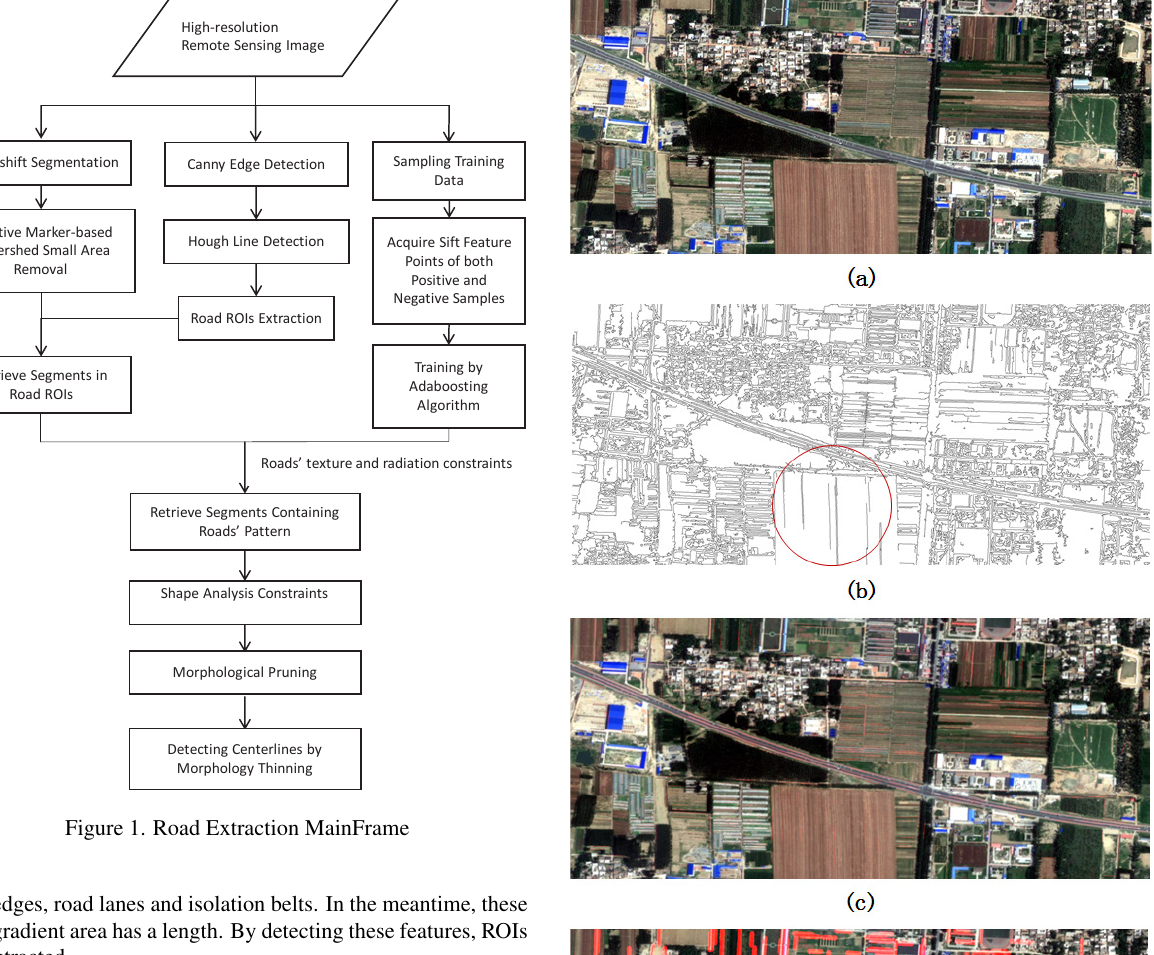
with 1 channel according to human visual property, the equation is shown in 1